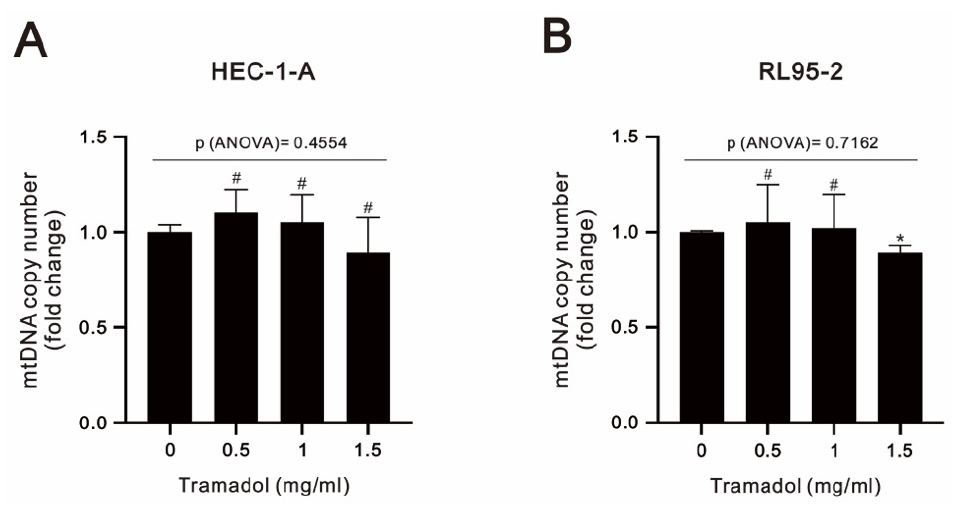
Figure 8. Effects of tramadol on the mtDNA copy number of human endometrial cancer cells. ( A , B ) HEC-1-A and RL95-2 cells were treated with tramadol (0, 0.5, 1, and 1.5 mg/mL) for 24 h. Bars depict the mean ± SD of three independent experiments. Student’s t -tests were performed, and the results were compared with the vehicle. # p > 0.05 and * p < 0.05 (Student’s t -test). ( A , B ) The means between the groups were analyzed by one-way ANOVA.